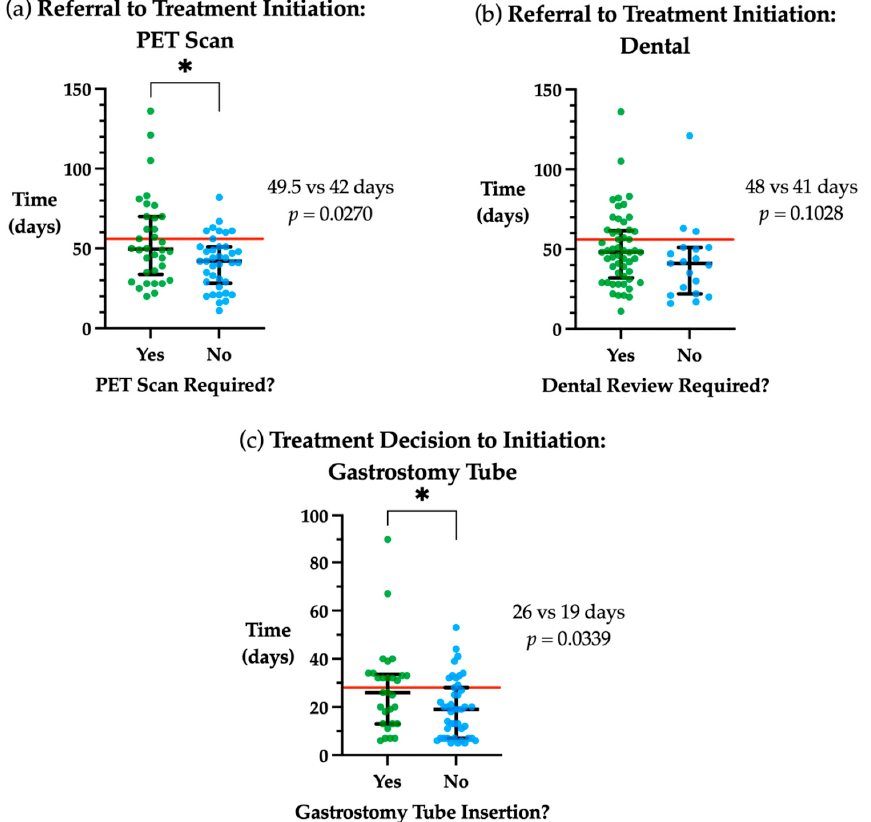
sion to initiation. Median and interquartile range plotted in black. * p < 0.05.